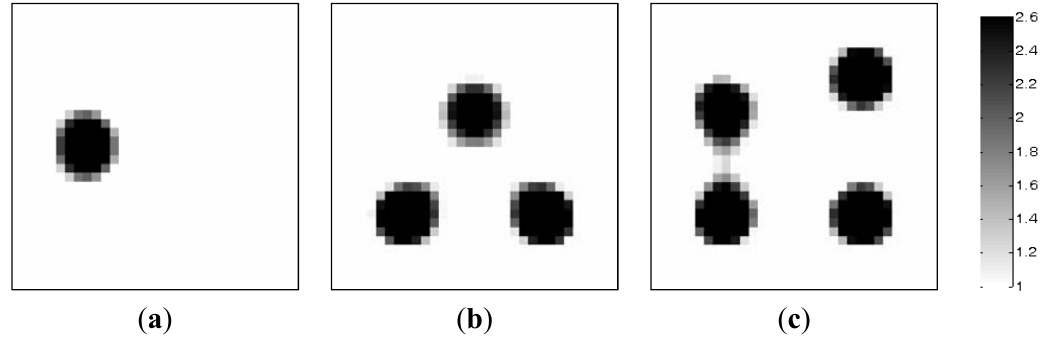
Figure 4. Reconstructed images by the MMVDR algorithm.